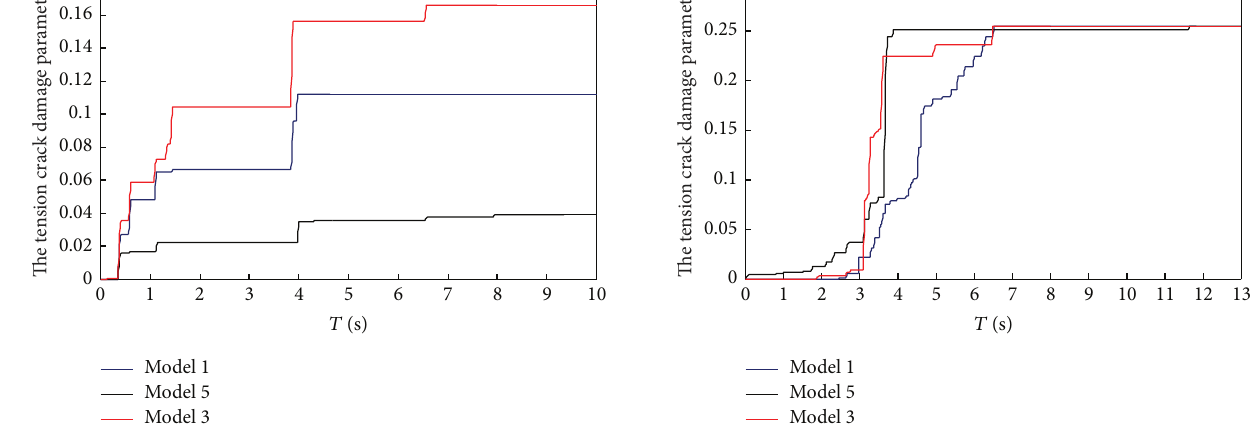
Figure 35: The tension crack damage parameter of pier between windows under Lixian County ground motion.